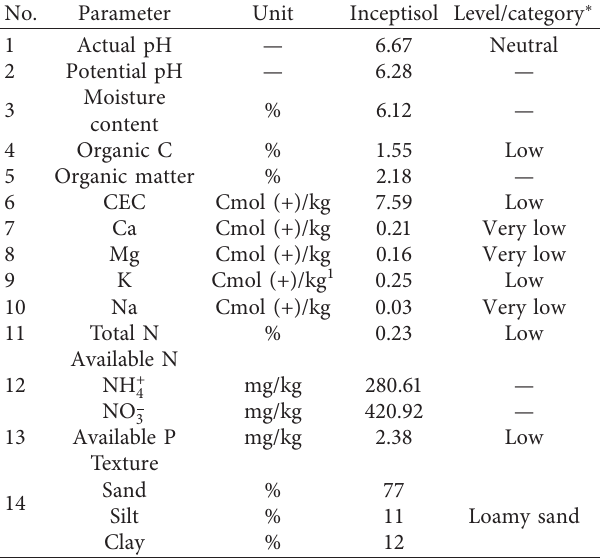
Table 1: Chemical and physical properties of